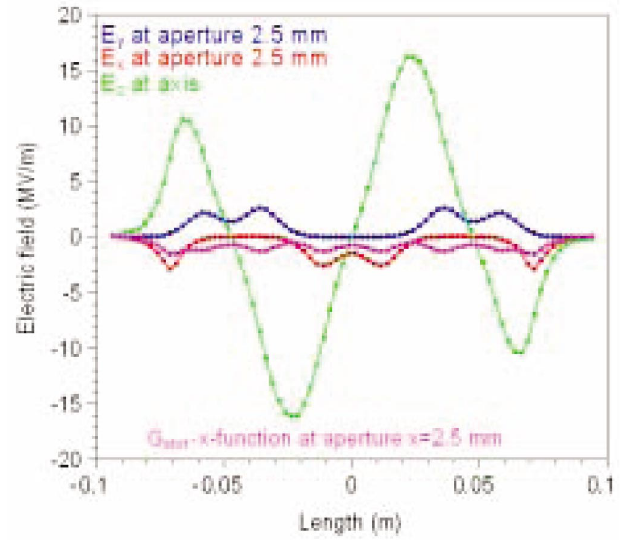
(cid:6) x function in slot 0 (cid:4) peak